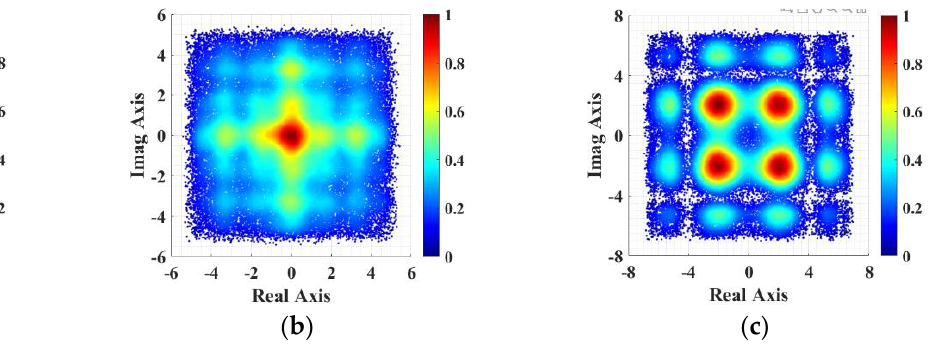
Figure 4. The PDF of n-level polybinary transformation for QPSK signal under the time-packing factor of 0.5: ( a ) original QPSK signal; ( b ) after duobinary transformation; ( c ) after tribinary trans- formation.